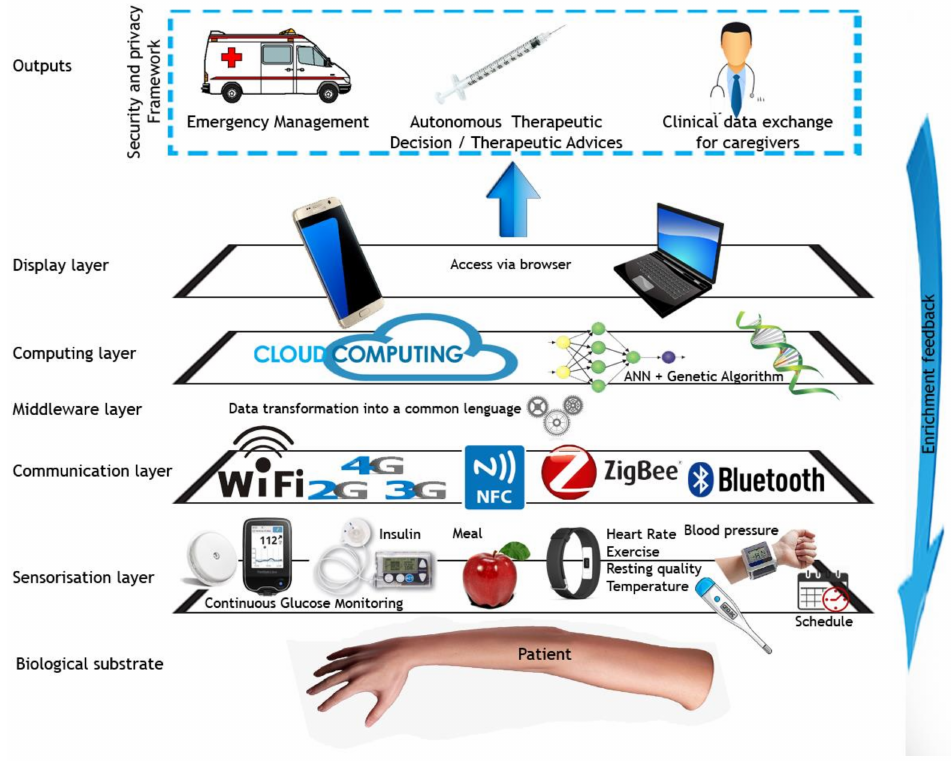
Figure 1. Proposed layered structure for an artificial